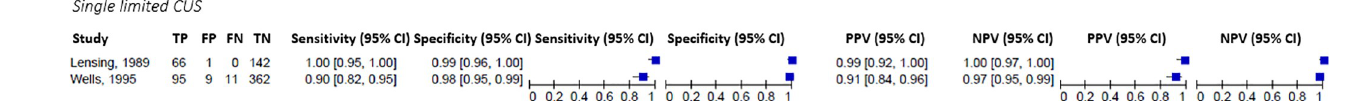
Fig 3. Forest plots diagnostic accuracy of compression ultrasonography in studies that used contrast venography as a reference standard. Abbreviations: CI: confidence interval, CUS: compression ultrasonography, FN: false negative, FP: false positive, NPV: negative predictive value, PPV: positive predictive value, TN: true negative, TP: true